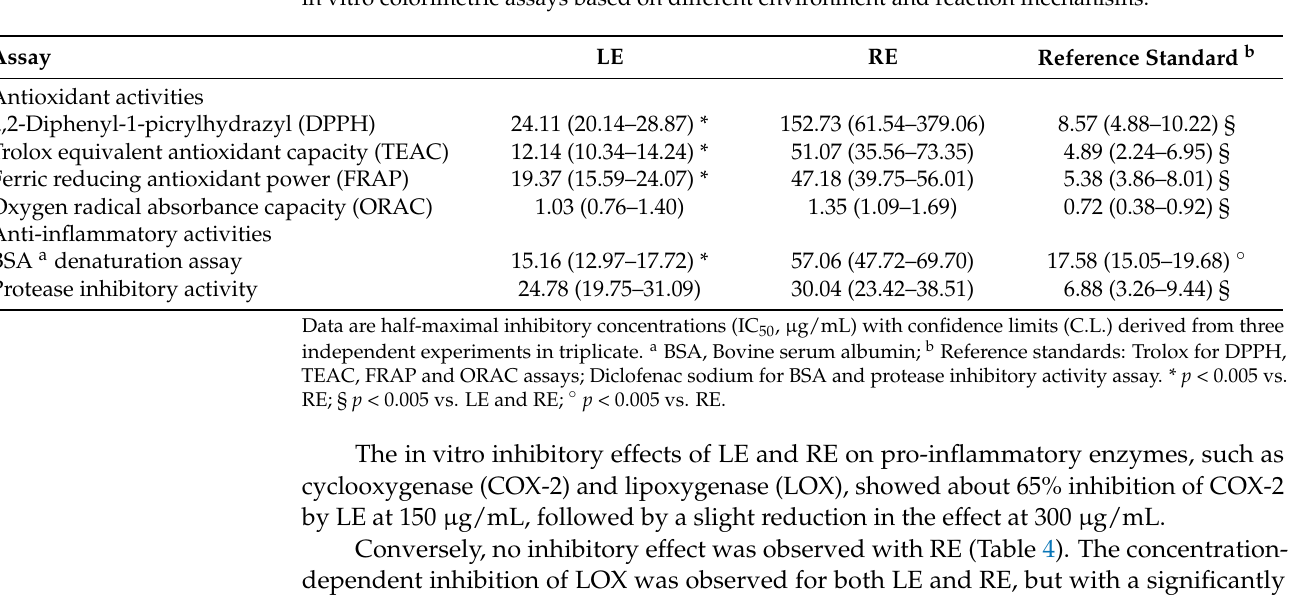
Table 3. Determination of antioxidant and anti-inflammatory activities of LE and RE by several in vitro colorimetric assays based on different environment and reaction mechanisms.